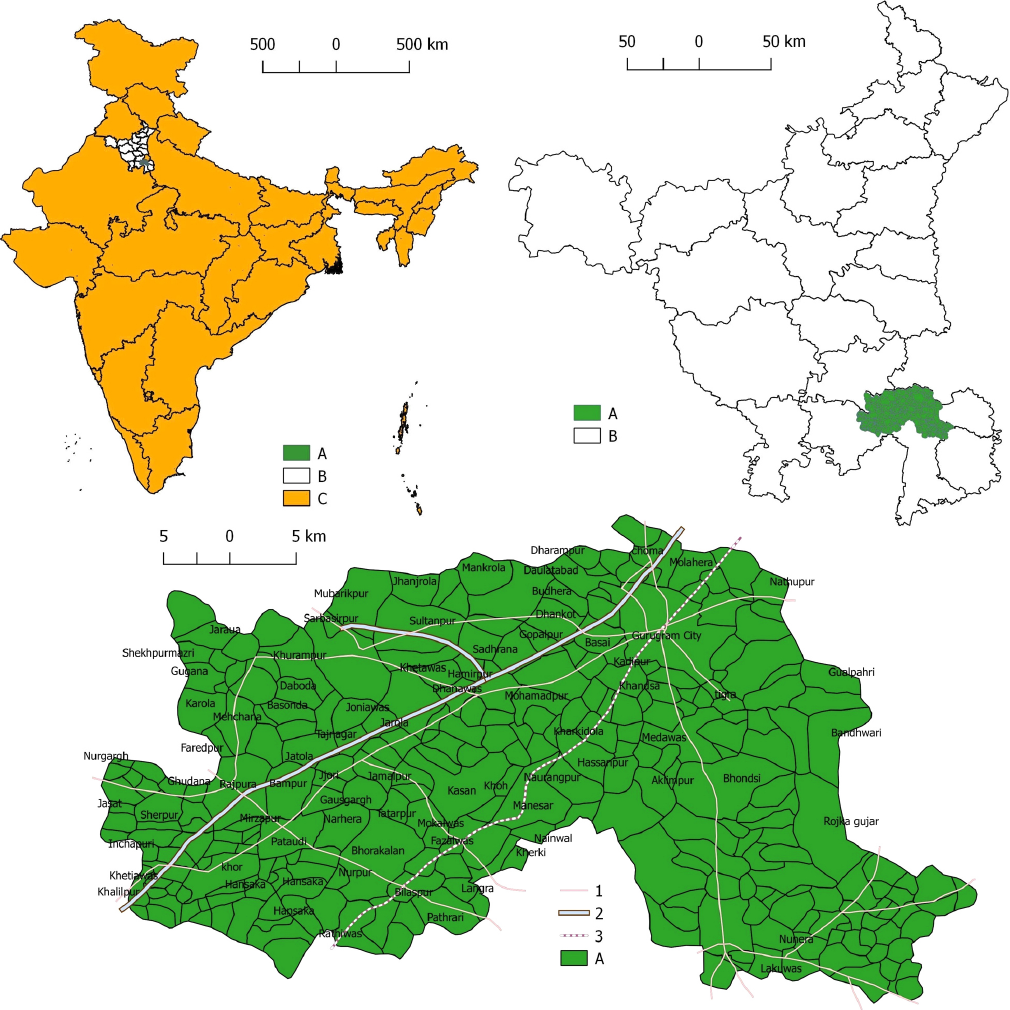
Fig. 1. Location map of the study